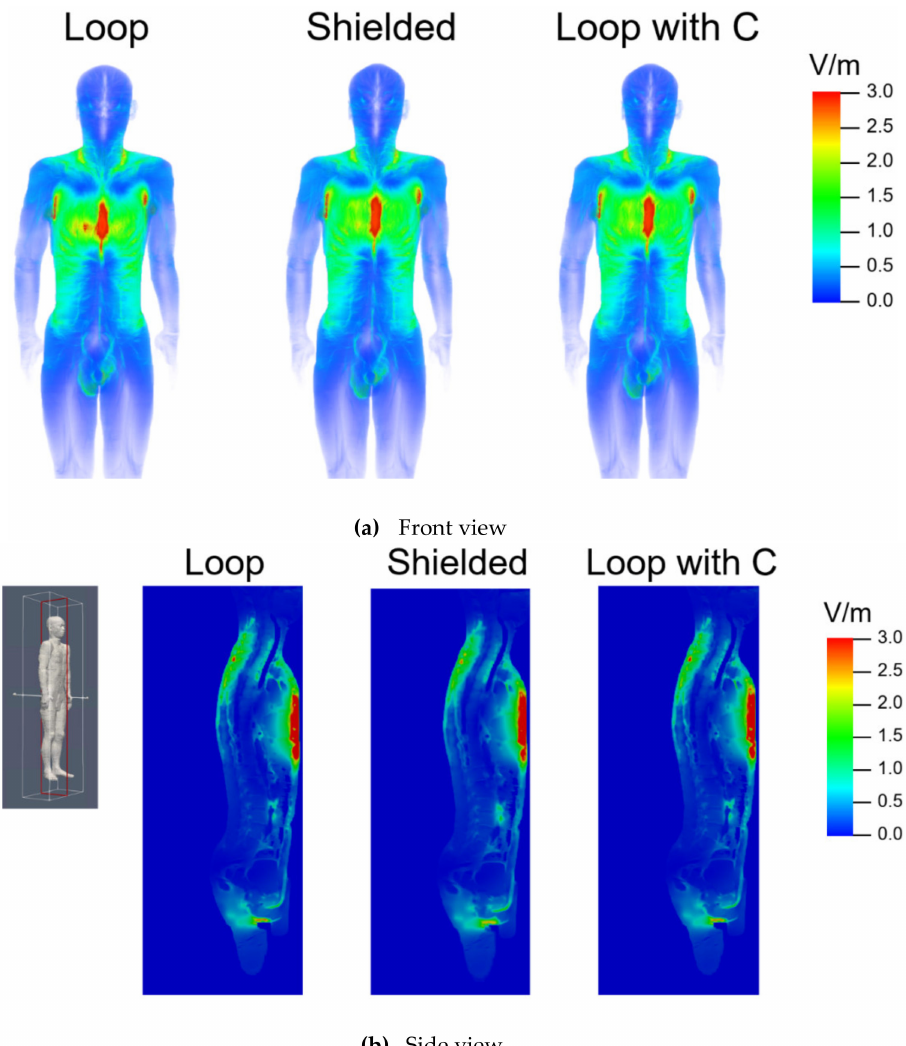
Figure 7. Internal electric field distribution in human